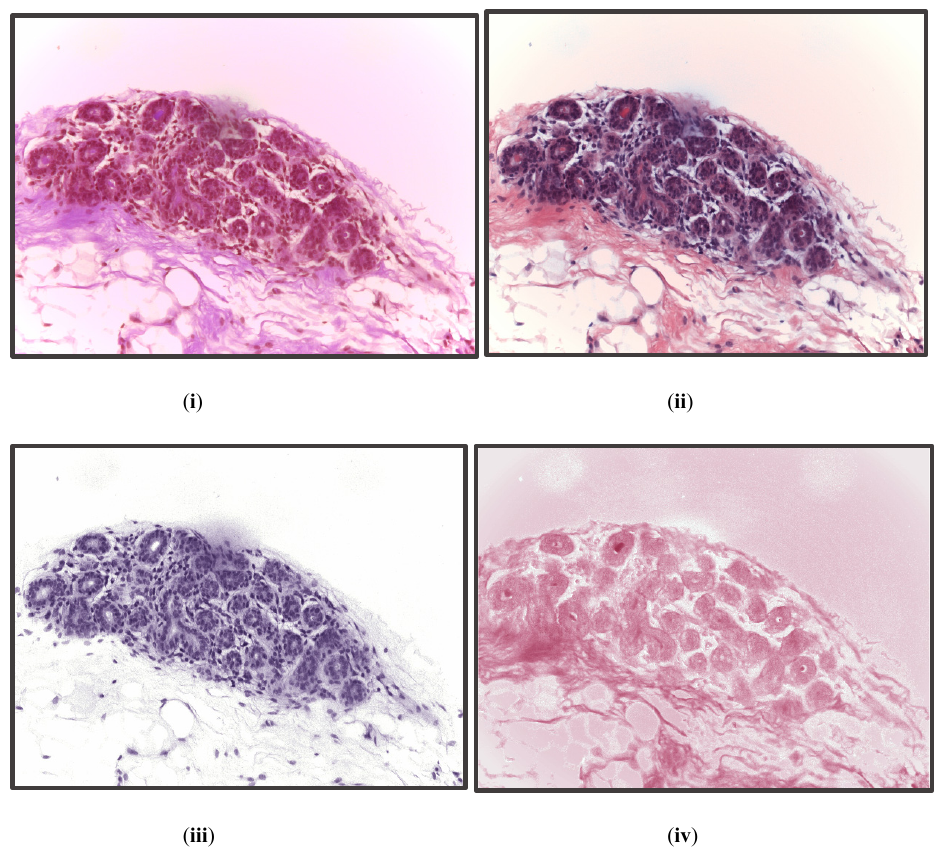
Figure 4. From top left in a clockwise direction: ( i ) original image, ( ii ) stain normalized image ( iii ) hematoxylin stain, and ( iv ) eosin stain.